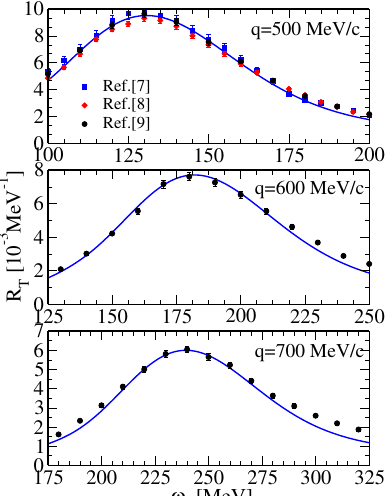
Figure 1. Inelastic transverse response function R T ( q ; ! ) of 3